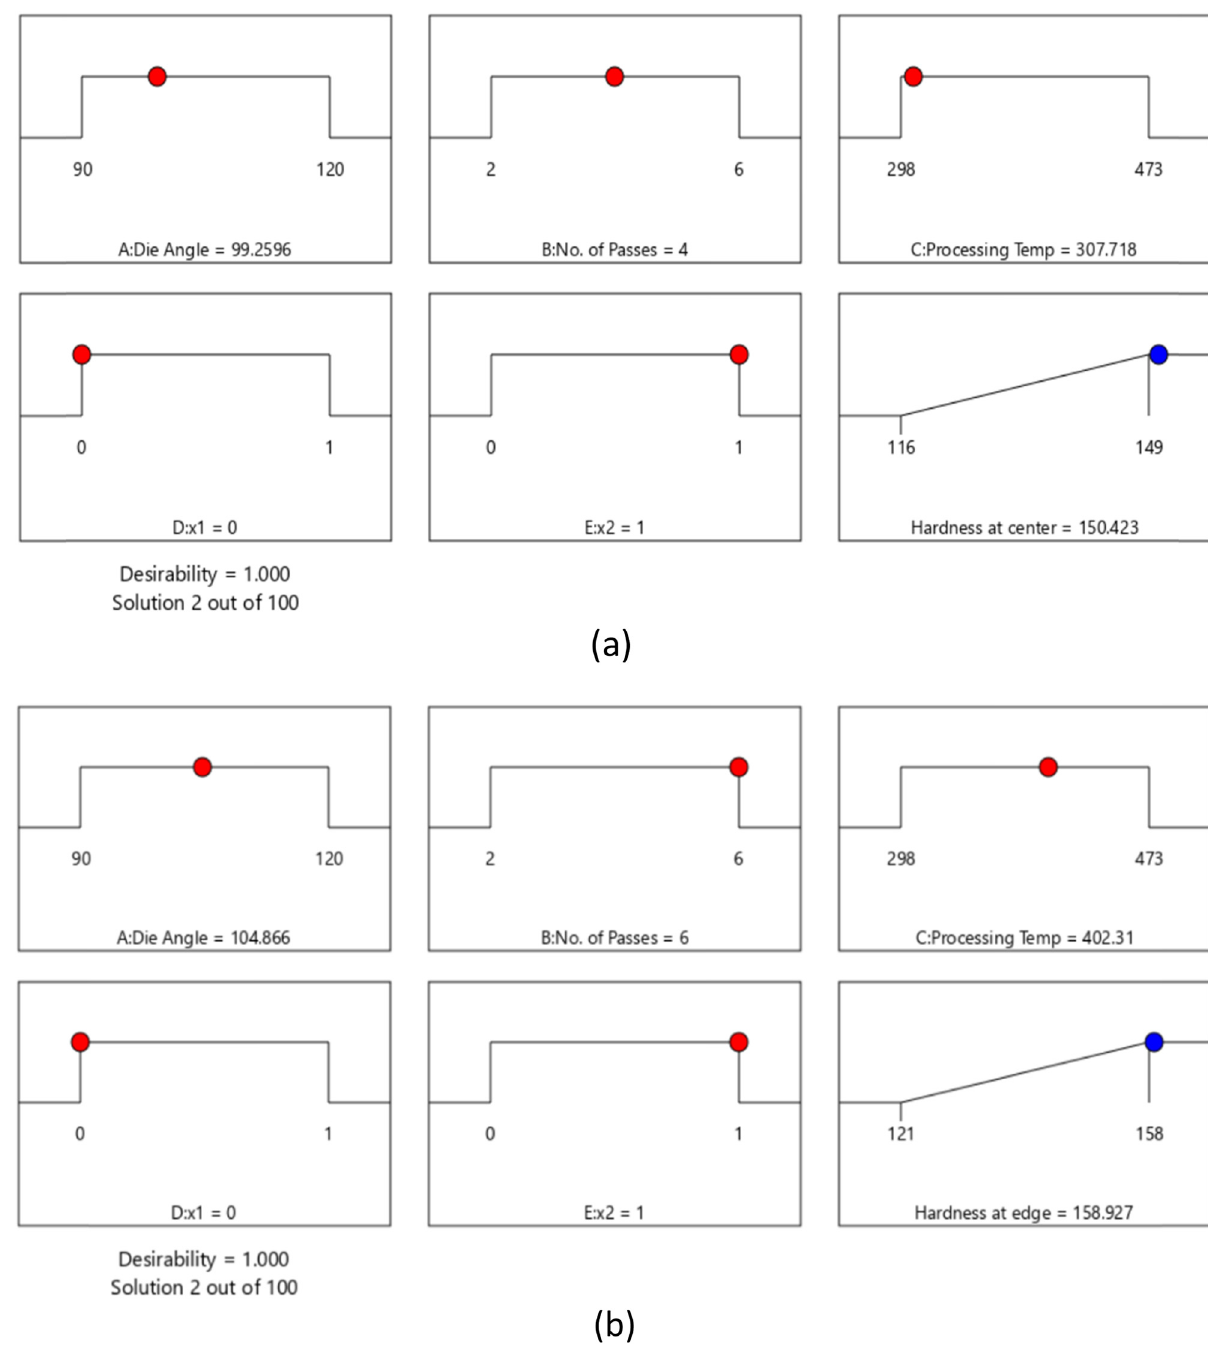
Figure 19: RSM optimization results of ( a ) H C and ( b ) H E